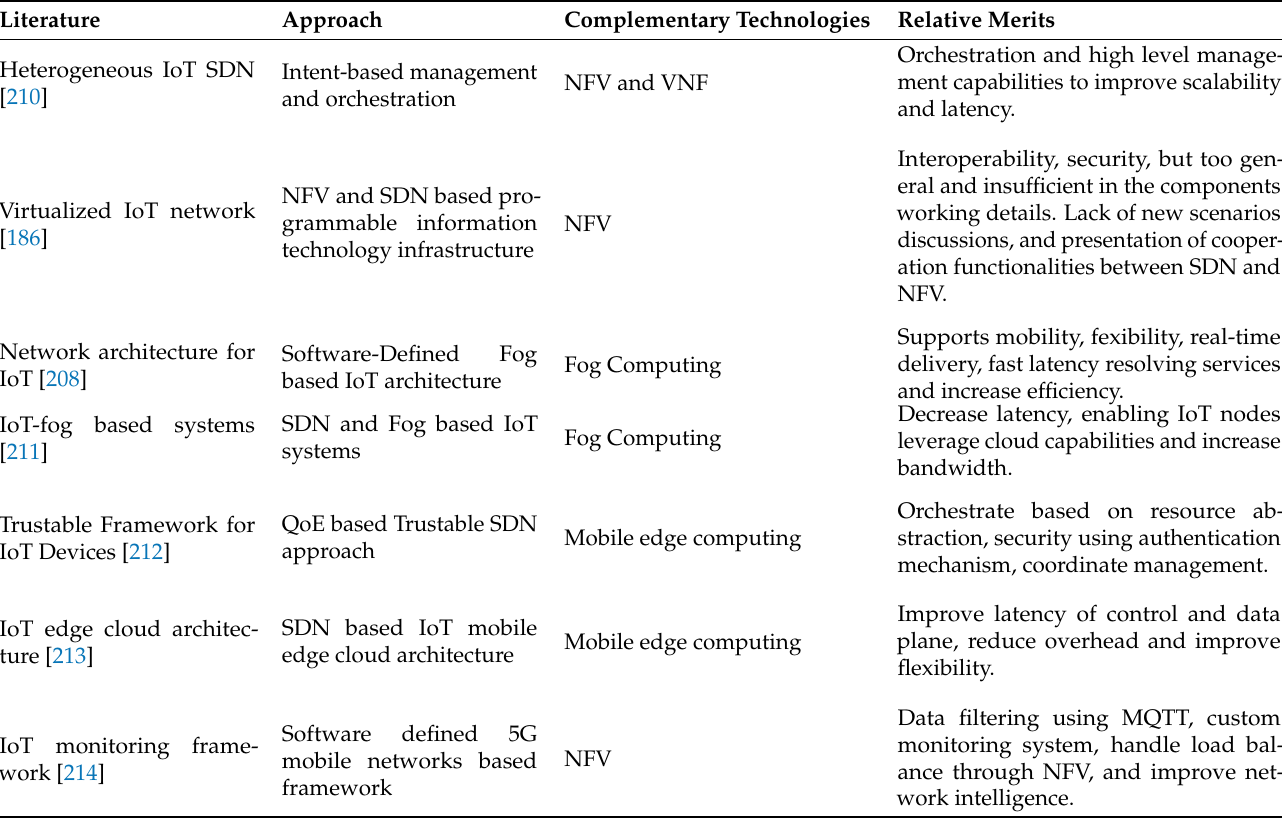
Table 6. Real world